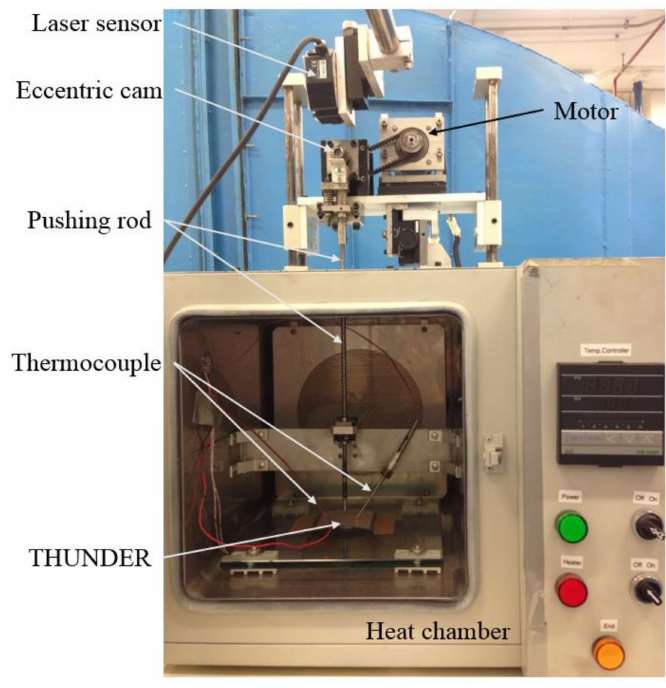
Figure 7. Heat chamber with a THUNDER